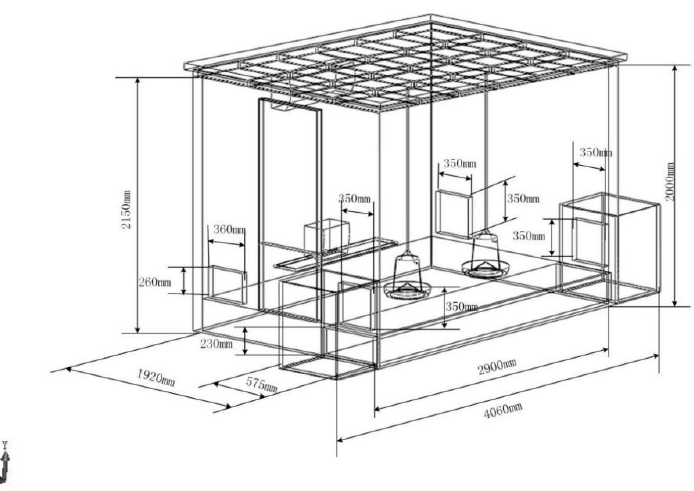
Figure 2. The structure and dimensions of the experimental broiler chamber.